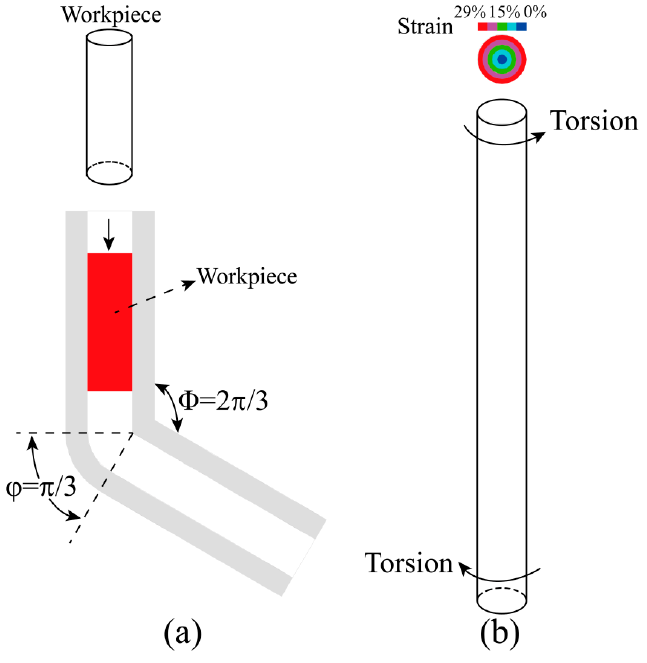
Figure 2. Schematics of two deformation modes: ( a ) equal channel angular pressing (ECAP); ( b ) pure torsion.